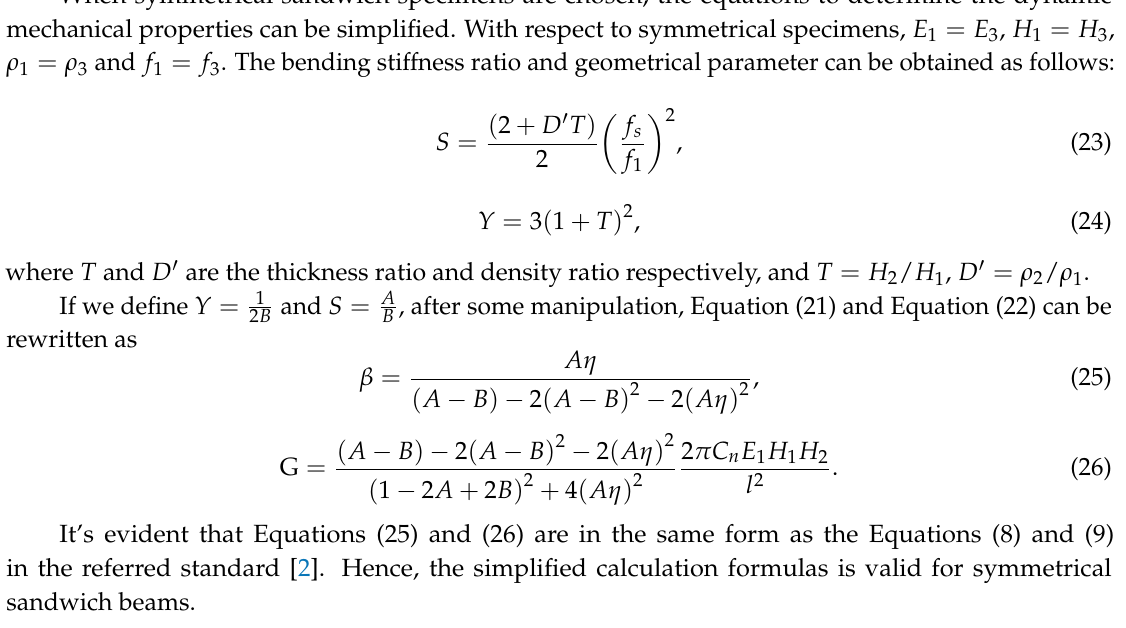
3000 (a) Figure 3. Simulation results of constant loss factor and shear modulus by three sandwich beams: ( a ) modal loss factors and ( b ) modal shear moduli.